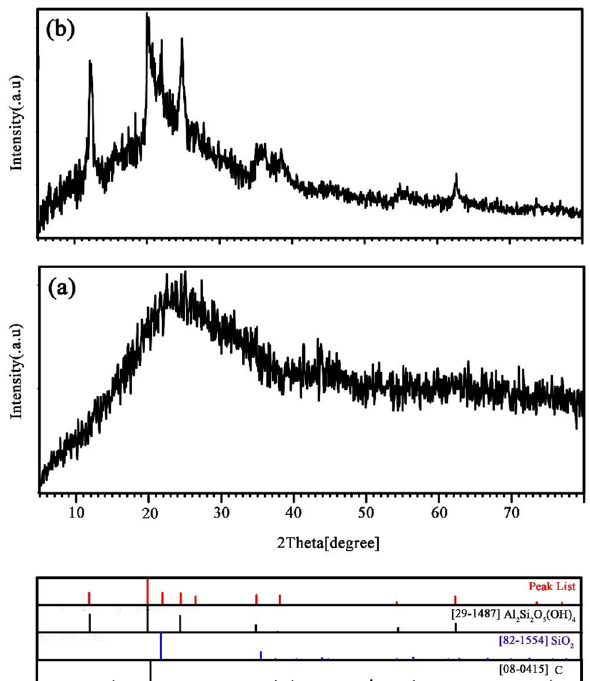
Figure 2. XRD diffractograms of ( a ) pristine S, N-doped GQDs and ( b ) S, N-GQD/HNT